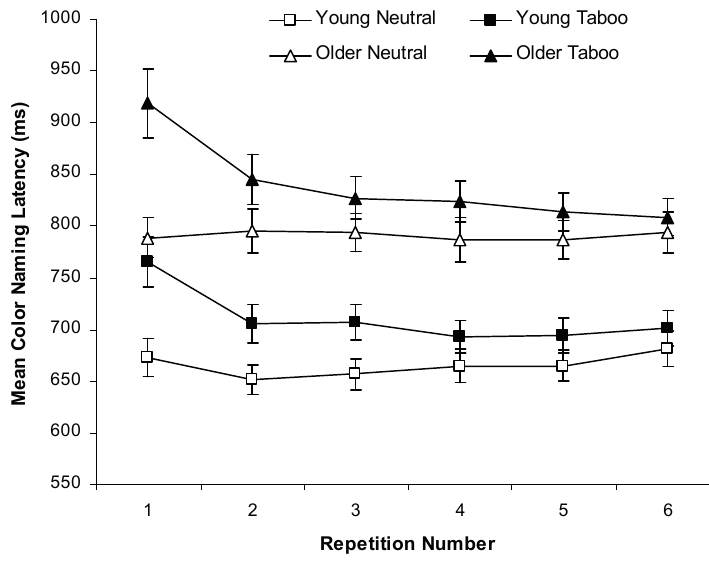
Figure 2. Mean color-naming response times (RTs) (± SE ) for repetitions 1–6 of neutral vs. taboo words for young adults and older adults in Experiment 1.